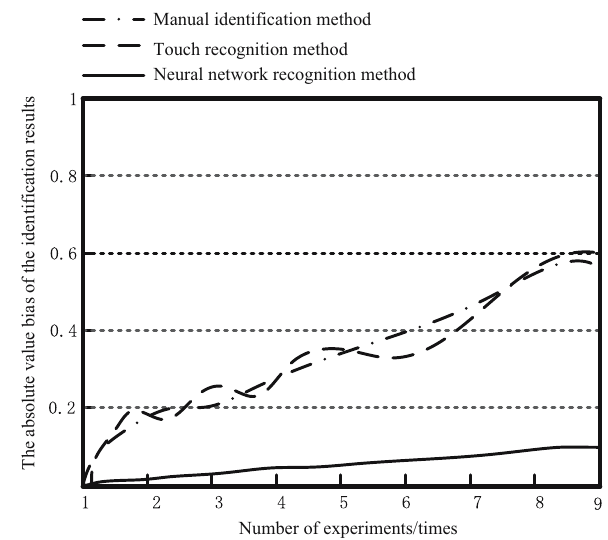
Figure 6: Absolute value deviation of recognition results by di ff erent